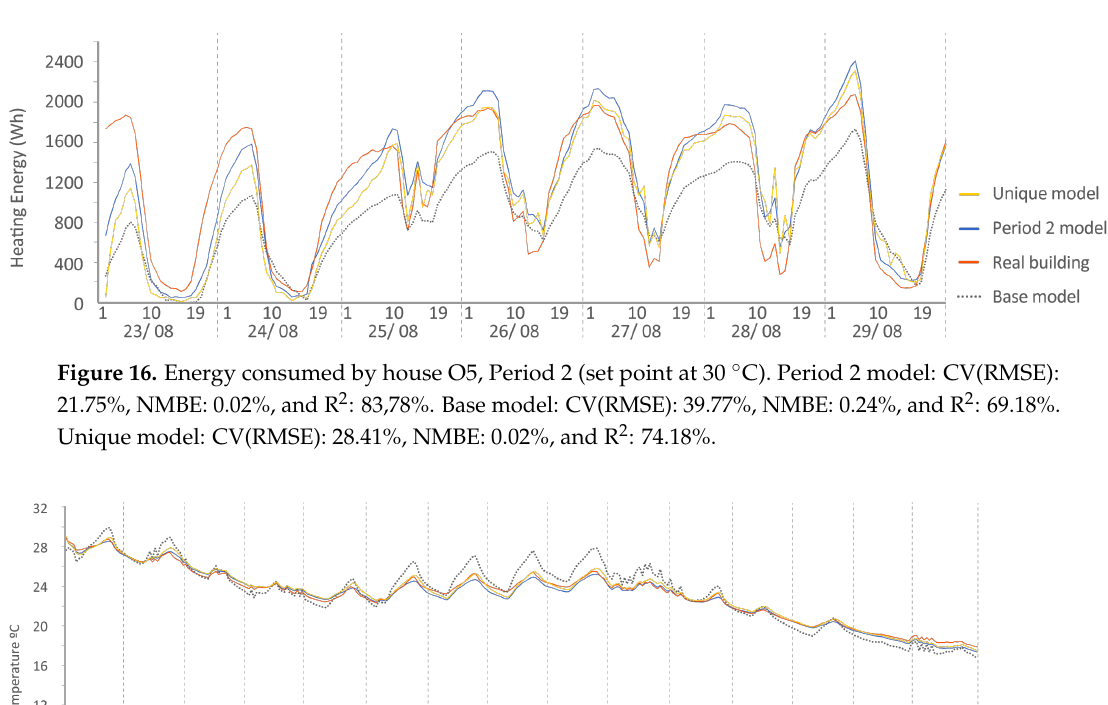
Figure 15. Energy consumed by the N2 house. Period 2 (set point at 30 ◦ C). Period 2 model: Coefficient of Variation of Mean Square Error (CV(RMSE)): 9.06% Normalized Mean Bias Error (NMBE): 0.02% R 2 : 92.70%. Base model: CV(RMSE): 29.05% NMBE: 0.21% R 2 : 91.93%. Unique model: CV(RMSE): 9.65% NMBE: 0.04% R 2 : 91.80%.